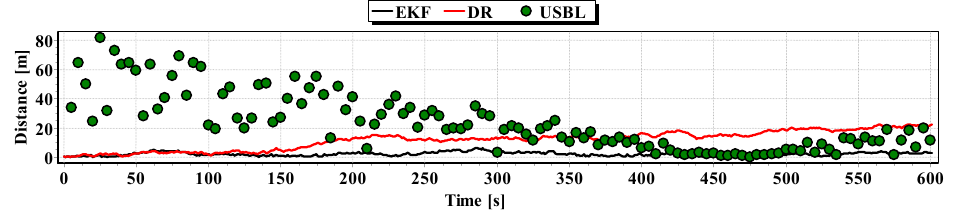
Figure 15. Graph of the reference position distance from the position estimated by EKF and DR methods and determined by the USBL system (single passage). Table 2. Parameters of statistical positioning errors by EKF, DR, and USBL system (single passage).